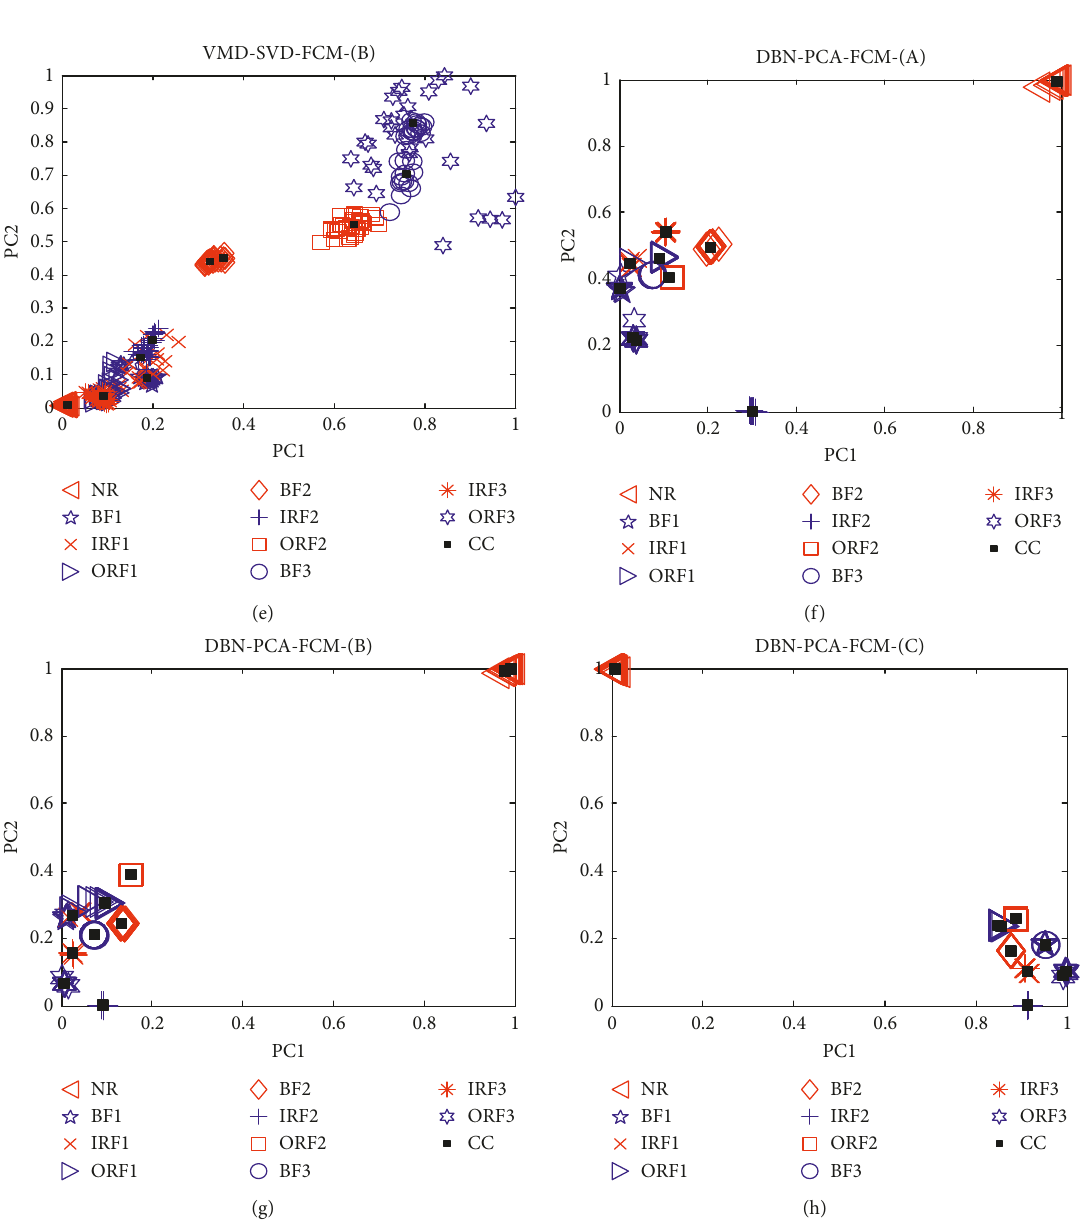
Figure 8: 2-dimensional clustering with DBN-PCA-FCM: (a, c, f) dataset A; (b, d, e, g) dataset B; (h) dataset C.